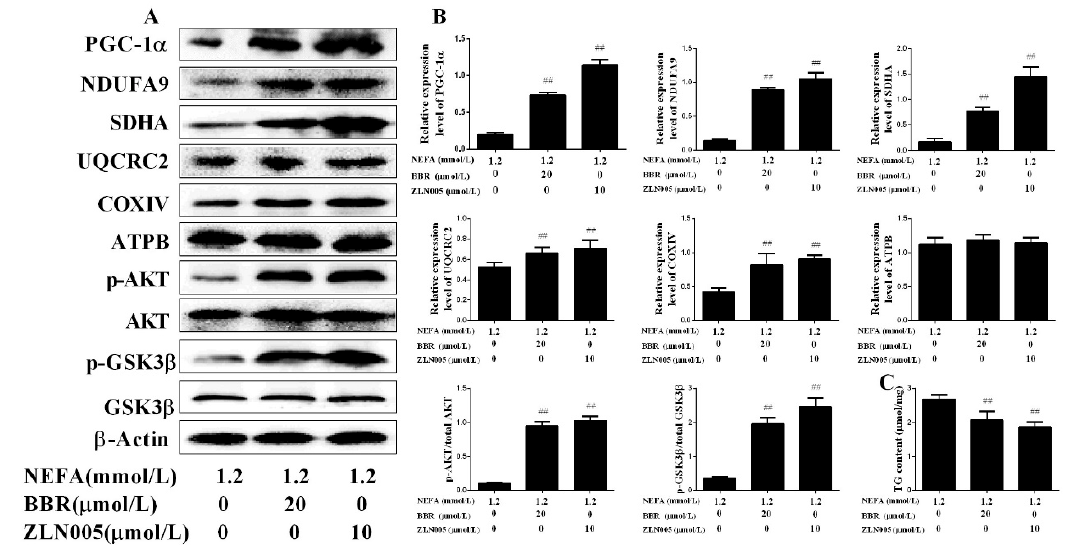
Figure 8. Activation of PGC-1 α increased the beneficial effects of BBR on mitochondrial respiratory chain function and insulin signaling damage induced by NEFA. Hepatocytes were assigned to 3 groups as follows: A 1.2 mmol/L NEFA group, a 1.2 mmol/L NEFA + 20 μ mol/L BBR treatment group, and a 1.2 mmol/L NEFA + 10 μ mol/L ZLN005 treatment group. ( A , B ) Western blot analysis and quantification of key molecules of the insulin signaling pathway, PGC-1 α , and five representative subunits of OXPHOS complexes, and β -Actin served as an internal control; ( C ) TG content in bovine hepatocytes. Quantified data are mean ± SD; ## p < 0.01 versus NEFA group.